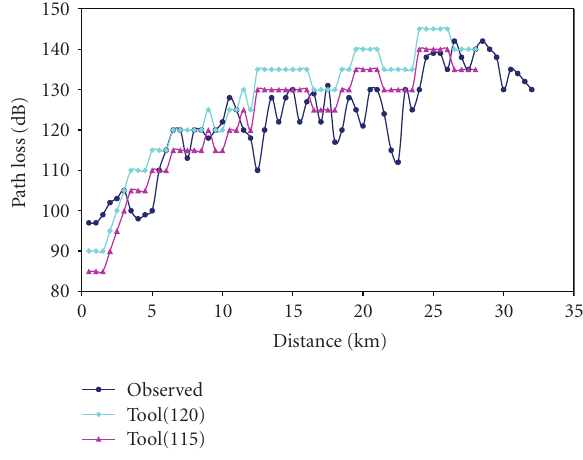
Figure 10: Comparison of tool predicted losses with observed losses versus track distance for Karjat base station.